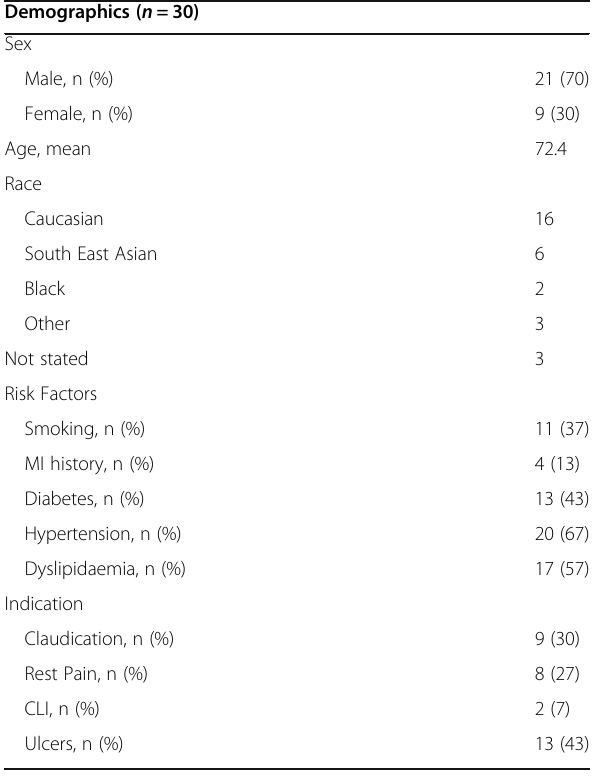
Table 3 Demographic data of patient